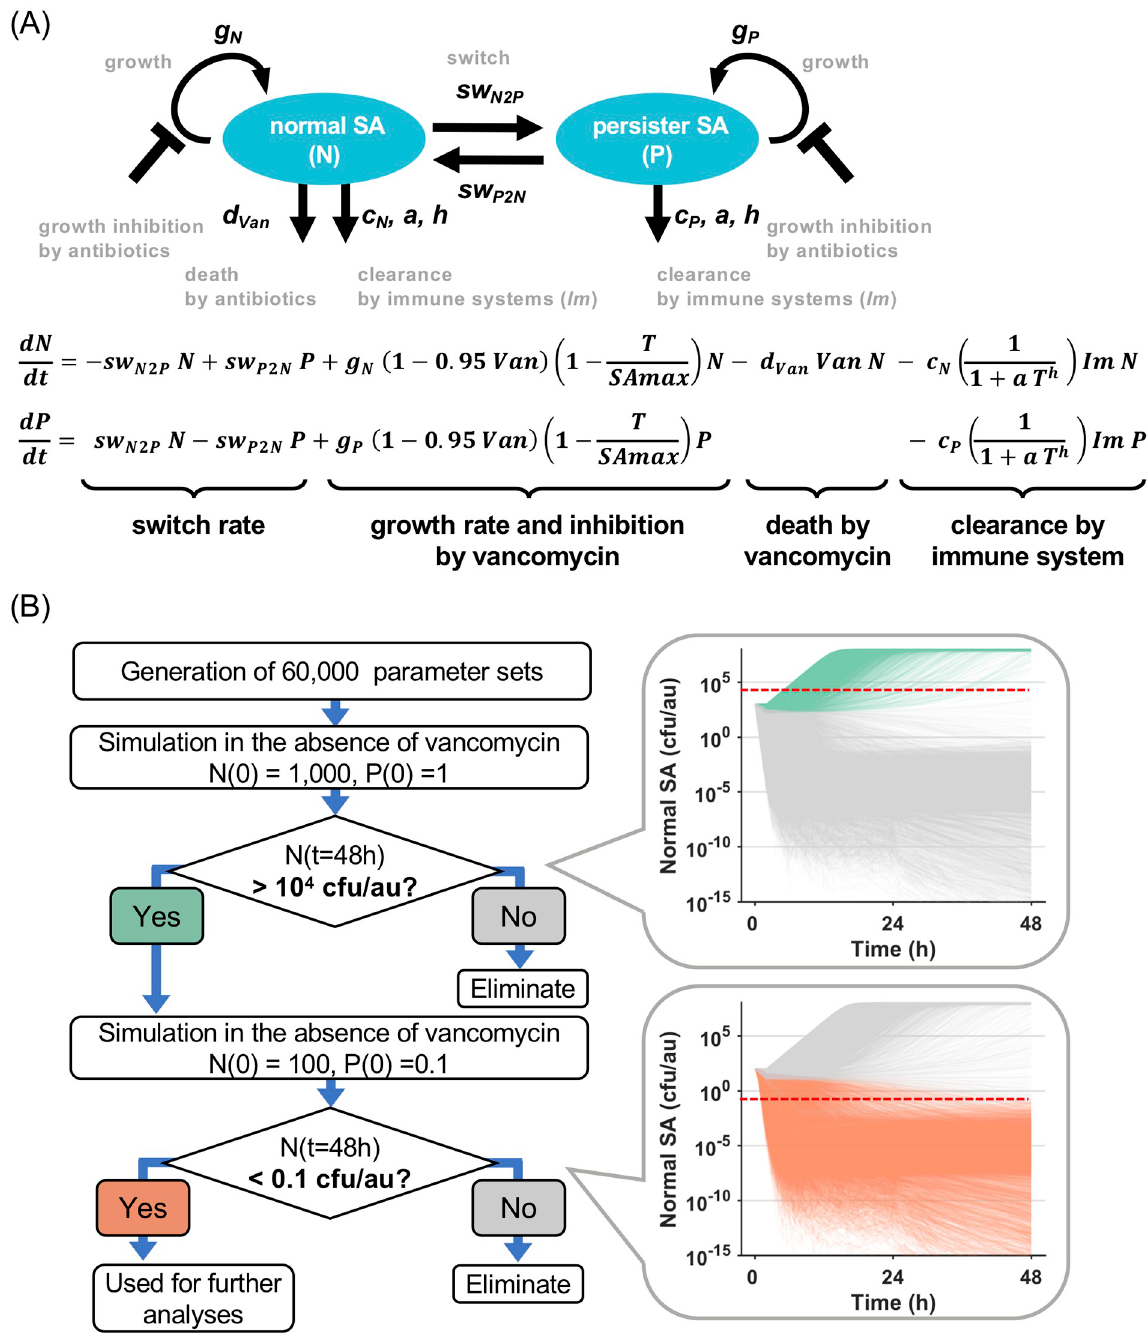
Fig 2. Schematic diagram of the mathematical model of in vivo MRSA populations and ensemble modeling. (A) The diagram depicts the two state variables as blue ovals, whose abundances are controlled by growth, death by antibiotics, clearance by the immune system ( Im ), as well as switch rates. Antibiotic treatment, vancomycin ( Van ), affects growth rates of both normal and persister and killing of the normal but not persister bacterium. The two differential equations are shown below the diagram. Van and Im are a binary value of 0 or 1 indicating absence or presence. (B) Algorithm for ensemble modeling to extract the sets of parameters (ensemble) using two criteria. All the models extracted had similar minimum inoculum doses to establish infection between around 100 to 1,000 colony-forming unit per arbitrary unit (cfu/a.u.). The parameter values randomized or fixed during the ensemble modeling are shown in Table